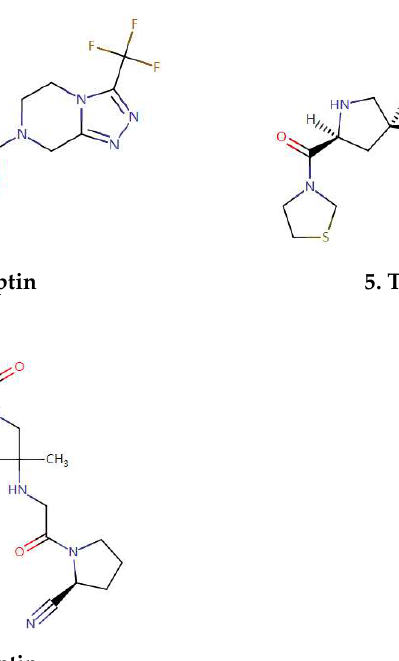
Figure 2. Molecular structures of gliptins.